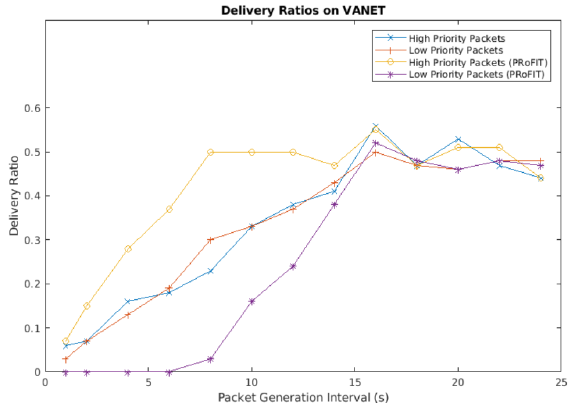
Figure 18. Delivery Ratios on